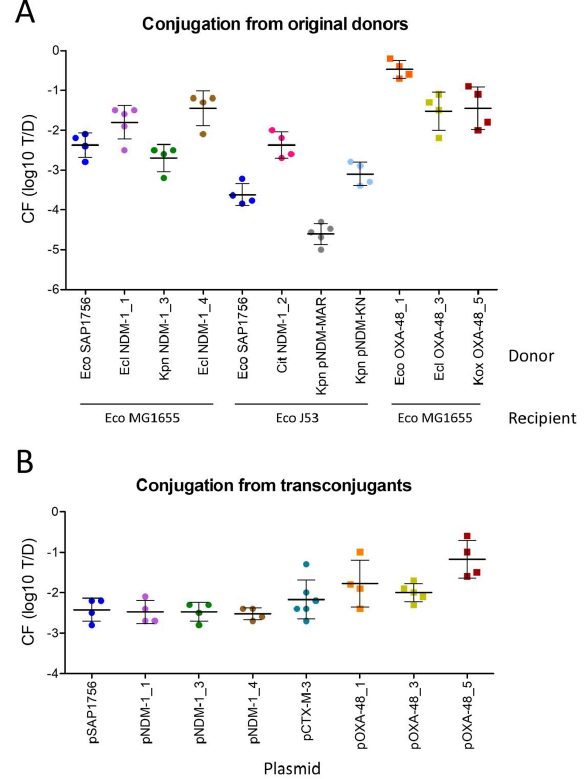
Figure 2. Conjugation frequency (CF) of IncL/M plasmids harbouring bla NDM-1 or bla OXA-48 genes, represented as the logarithm of transconjugants per donor obtained after 1 h conjugation at 37 ◦ C on LB agar. ( A ) Conjugation from the original donors to E. coli MG1655 (rifampicin or nalidixic acid spontaneous mutants), or J53 in cases where donors were resistant to both rifampicin and nalidixic acid. Plasmids encoding NDM-1 but belonging to other incompatibility groups were added for comparison (pNDM- MAR and pNDM-KN, IncH and IncA/C, respectively). ( B ) Conjugation from the transconjugants from A in E. coli MG1655 (spontaneous mutant resistant to nalidixic acid) to E. coli MG1655 (spontaneous mutant resistant to rifampicin). Circles represent the result of individual experiments with NDM-1-carrying IncM2 plasmids (except control plasmid pCTX-M-3, which is NDM-1-negative) and squares represent CF with IncL plasmids encoding OXA-48. Horizontal lines show the mean and vertical lines the standard deviation of at least 4 independent